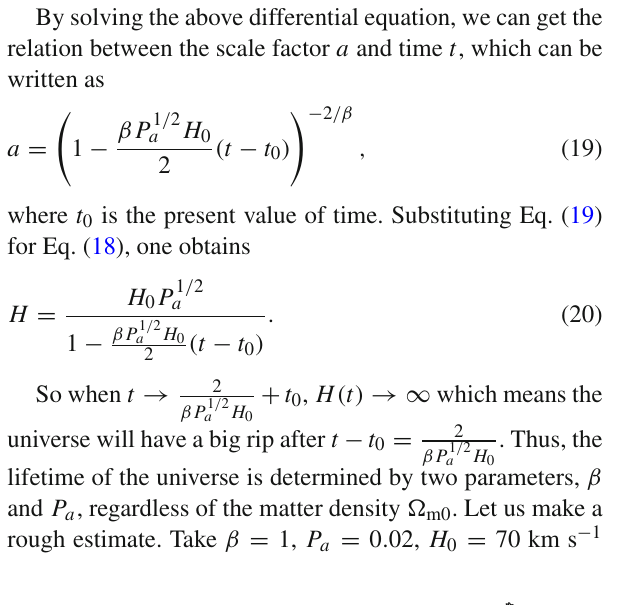
Fig. 2 The evolutions of ω de ,(cid:3) de , q and j . In each panel, The black line and red dashed line correspond to the GP parameterization and the (cid:4) CDM model, respectively, with the best-fit values listed in Table 3.